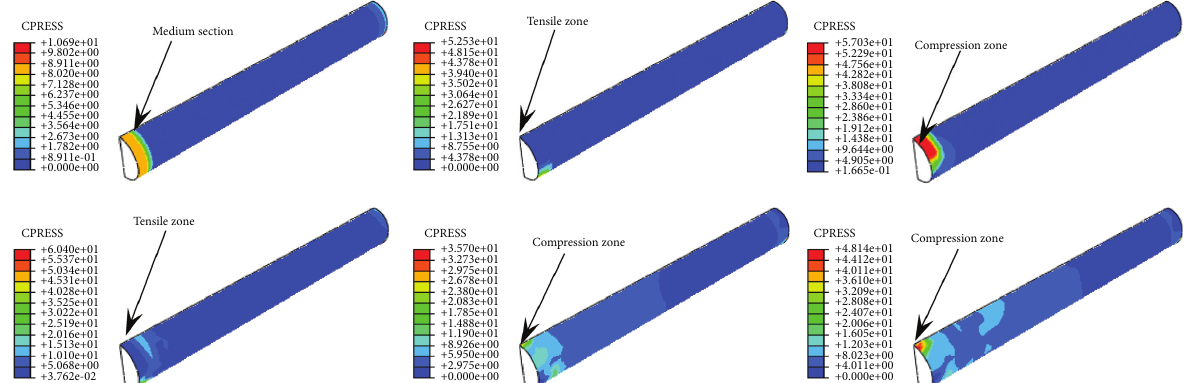
Figure 18: Distribution of interaction between steel tube and concrete in